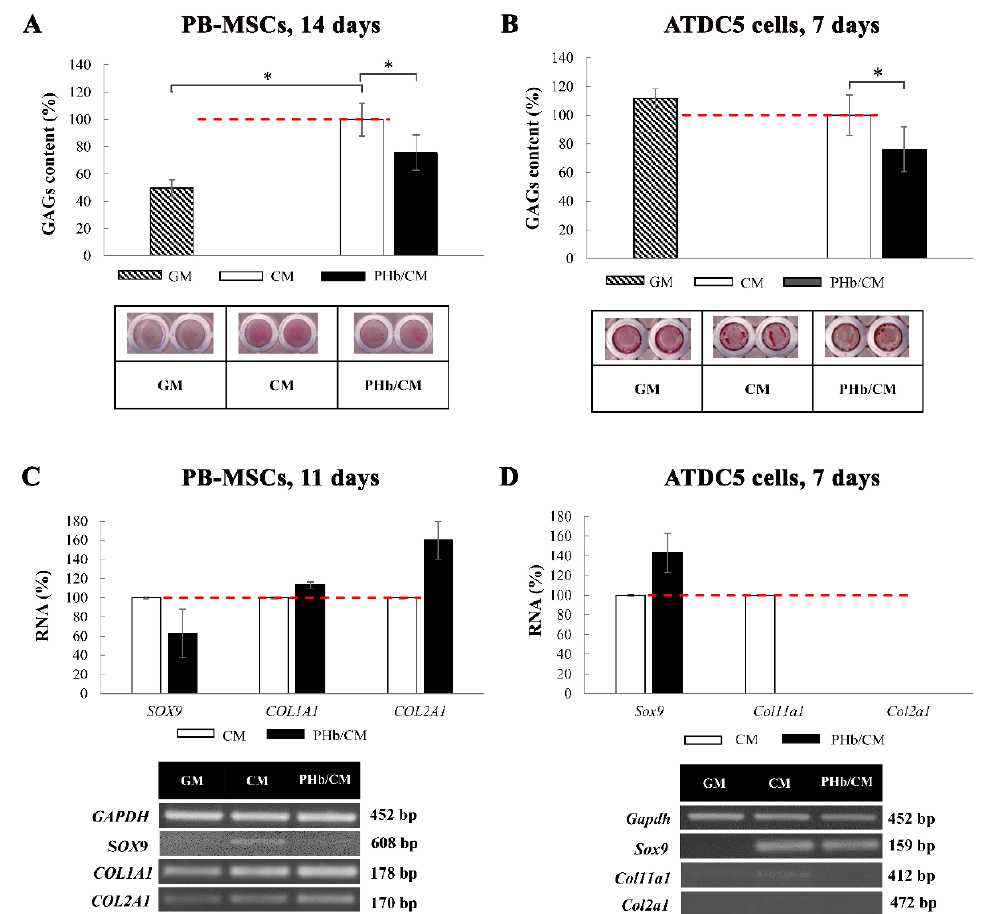
Figure 4. Acellular porcine hemoglobin (PHb) reduces chondrogenic differentiation capacity of mesenchymal cells. Chondrogenic differentiation of PB-MSCs and ATDC5 cells assessed by Safranin O staining of GAGs in PB-MSCs after 14 days ( A ) and ATDC5 cells after 7 days ( B ) of cultivation with or without 0.1 µM PHb in chondrogenic differentiation medium (CM). Intensity of the Safranin O staining in GM supplemented with PHb is presented as relative to control (CM, set as 100%). Mean ± SD of four independent experiments is shown; * p < 0.05, compared to the corresponding control. Chondrogenic differentiation of PB-MSCs was confirmed by RT-PCR of analysis of expression of SOX9 , COL1A1 , and COL2A1 genes after 11 days of cultivation ( C ) and Sox9 , Col11a , and Col2a1 genes in ATDC5 cells after 7 days of cultivation ( D ) in CM with or without PHb. GAPDH was used as a gel loading control. Representative RT-PCR bands are shown. The RT-PCR results are expressed as relative to corresponding control (CM, set as 100%). Mean ± SD of three independent experiments is shown.